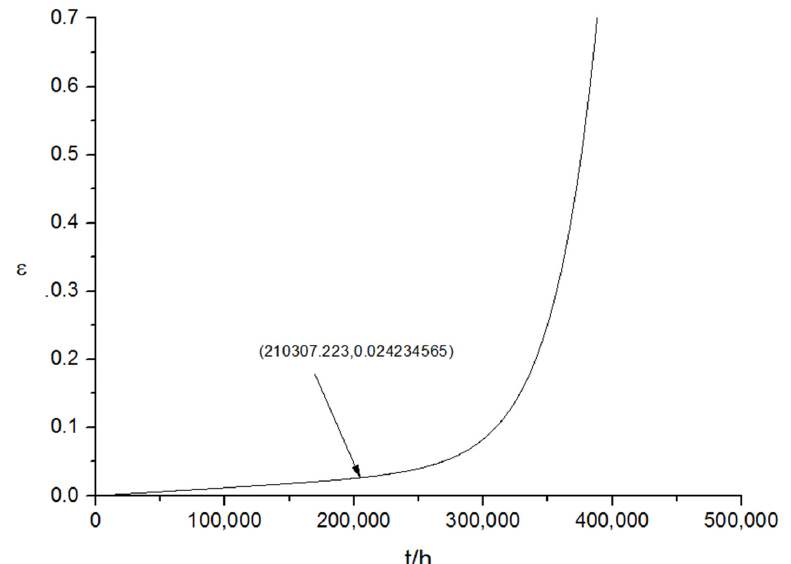
Figure 11. The creep fracture curve of the P22 pine.